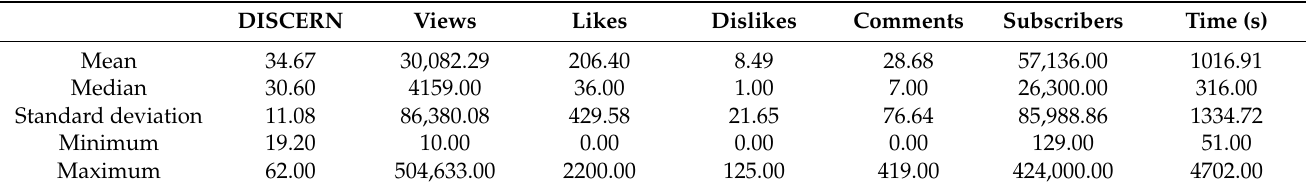
Table 2. Descriptive statistics for videos with misleading